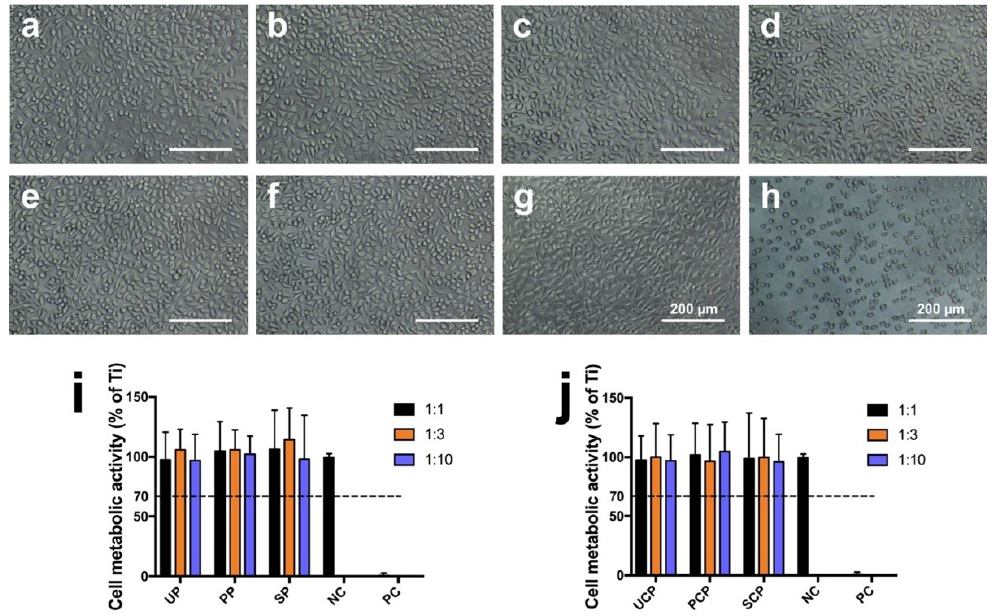
Figure 6. Cytotoxicity tests of L929 cells of PEEK and CFR‐PEEK 100% extracts: ( a ) untreated PEEK; ( b ) polished PEEK; ( c ) sandblasted PEEK; ( d ) untreated CFR‐PEEK; ( e ) polished CFR‐PEEK; ( f ) sandblasted CFR‐PEEK; ( g ) negative control (Ti); ( h ) positive control (Cu). Figure 6( i , j ) shows the quantitative result of the CCK‐8 test in the culture media with different extract concentrations of PEEK and CFR‐PEEK. The data are presented as means ± standard deviation. UP: untreated PEEK; PP: polished PEEK; SP: sandblasted PEEK; NC: negative control; PC: positive control; UCP: untreated CFR‐PEEK; PCP: polished CFR‐PEEK; SCP: sandblasted CFR‐PEEK. The dotted line indicates the toxicity threshold of 70% cell viability according to ISO 10993‐5 .